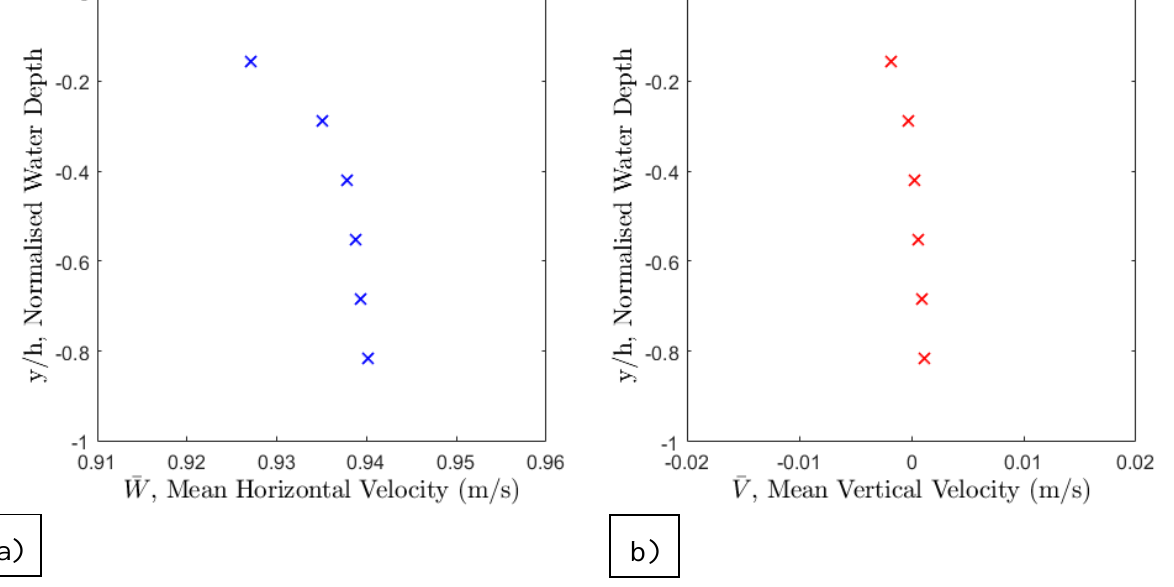
Figure 10. Averaged normalized: a) horizontal and; b) vertical velocities for current only flow through the water depth over 60s of converged run